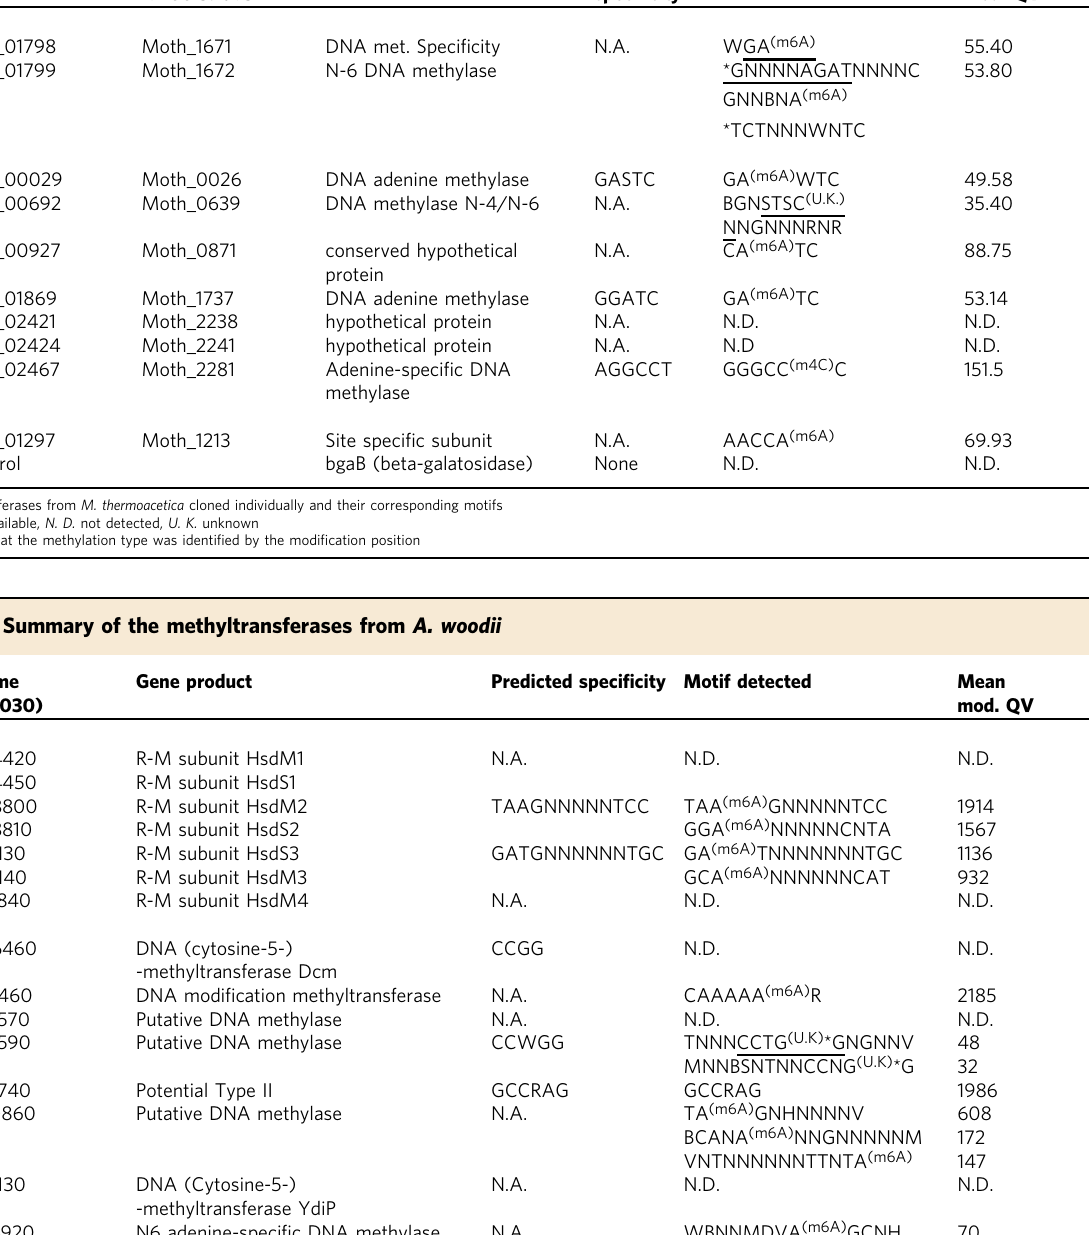
Table 2 Summary of the methyltransferases from M. thermoacetica Gene name ATCC